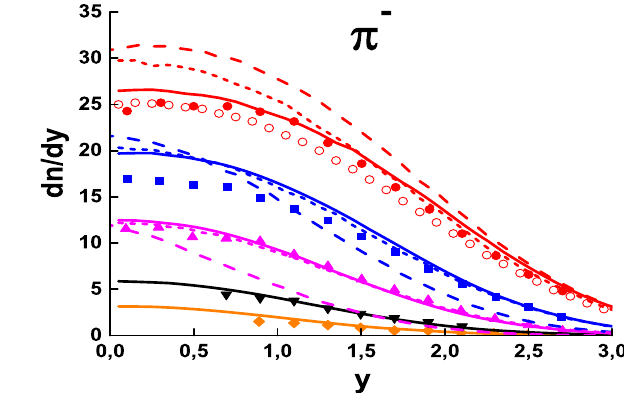
Fig. 5 Rapidity distributions of π + and π − mesons in 7 Be + 9 Be interactions. The points are the data measured by the NA61/SHINE collaboration [34]. The Geant4 FTF model calculations are shown by